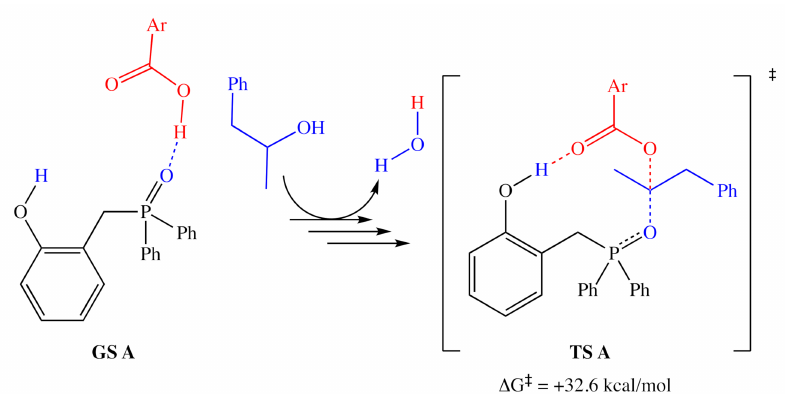
Figure 3. The resting state ( left ) and highest energy transition state ( right ) proposed by Houk and co-workers. Calculated energy accounts for both consumed alcohol and produced water. Ar =